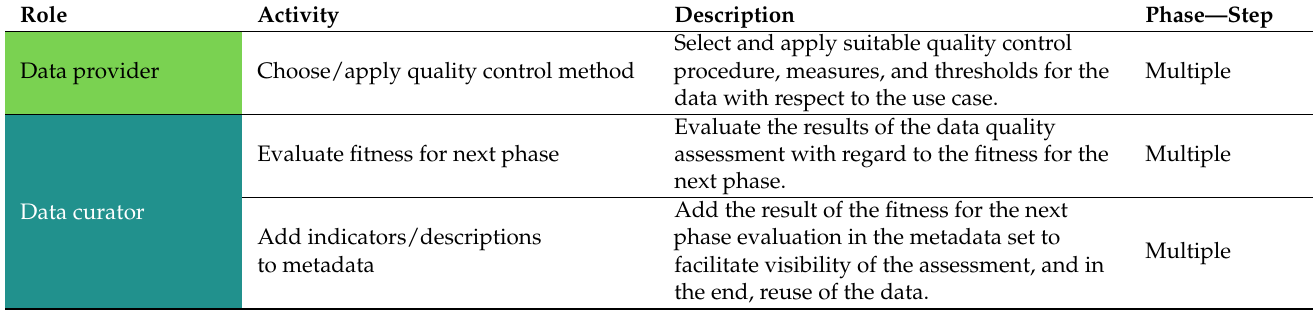
Table 9. Roles and related activities with descriptions for predefined quality control process.